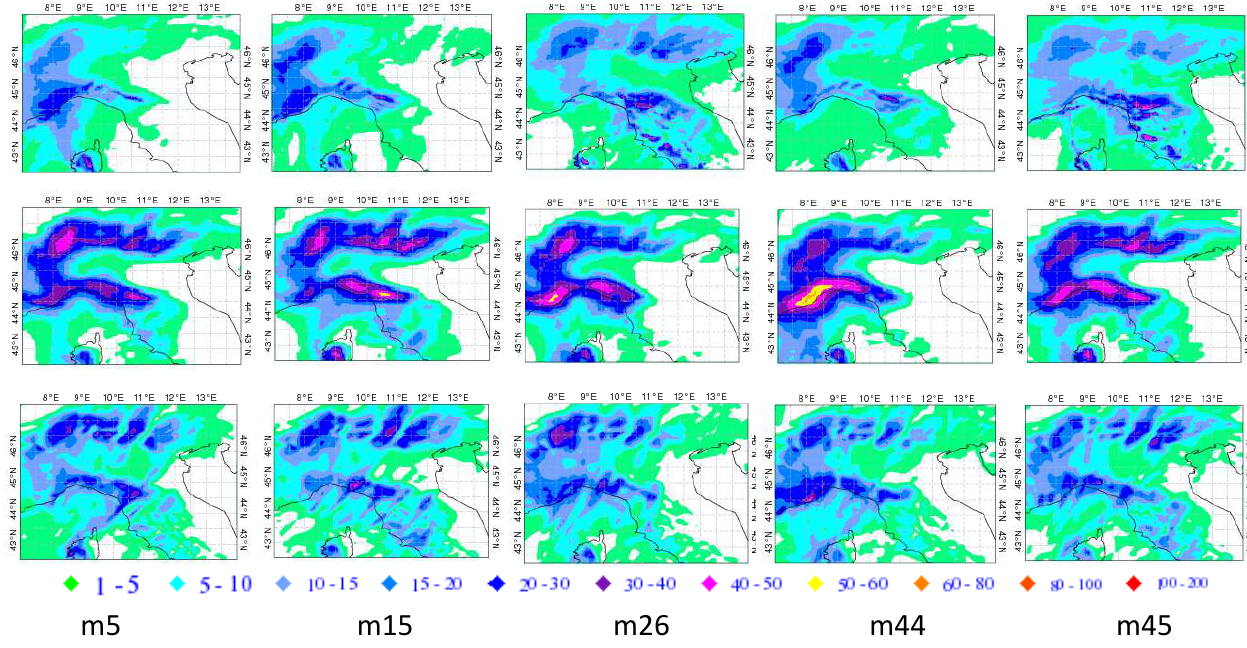
Fig. 10. As in Fig. 8 but for the forecasts initialized at 12:00UTC, 28 November 2008 (short range, + 36h; see text).